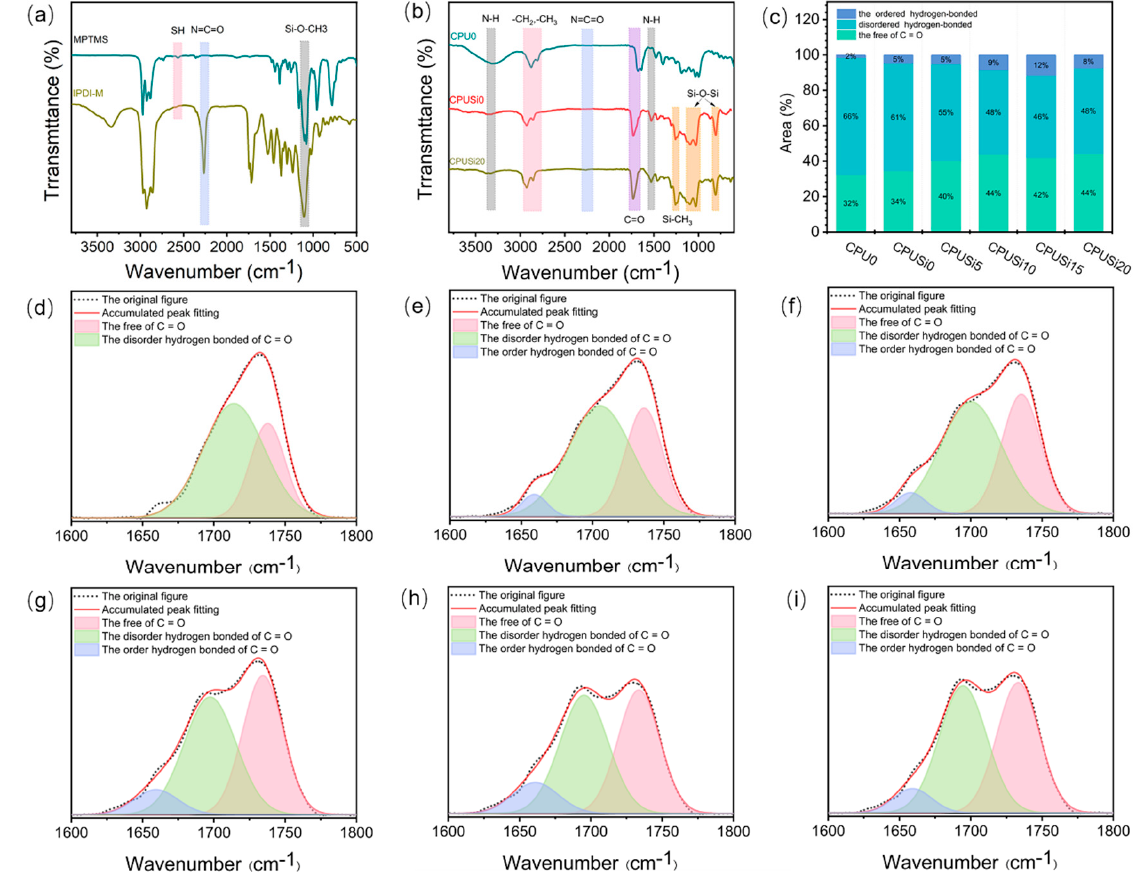
Figure 2. ( a ) FTIR spectra of MPTMS and IPDI-M; ( b ) FTIR spectra of the CPU0, CPUSi0, and CPUSi20 films; ( c ) Comparison of curve-fitting results of the C = O stretching region in CPU and CPUSi hybrids films; ( d – i ) Curve-fitting results of CPU0, CPUSi0, CPUSi5, CPUSi10, CPUSi15, and CPUSi20 at the wavenumber range of 1600–1800 cm –1 , respectively.